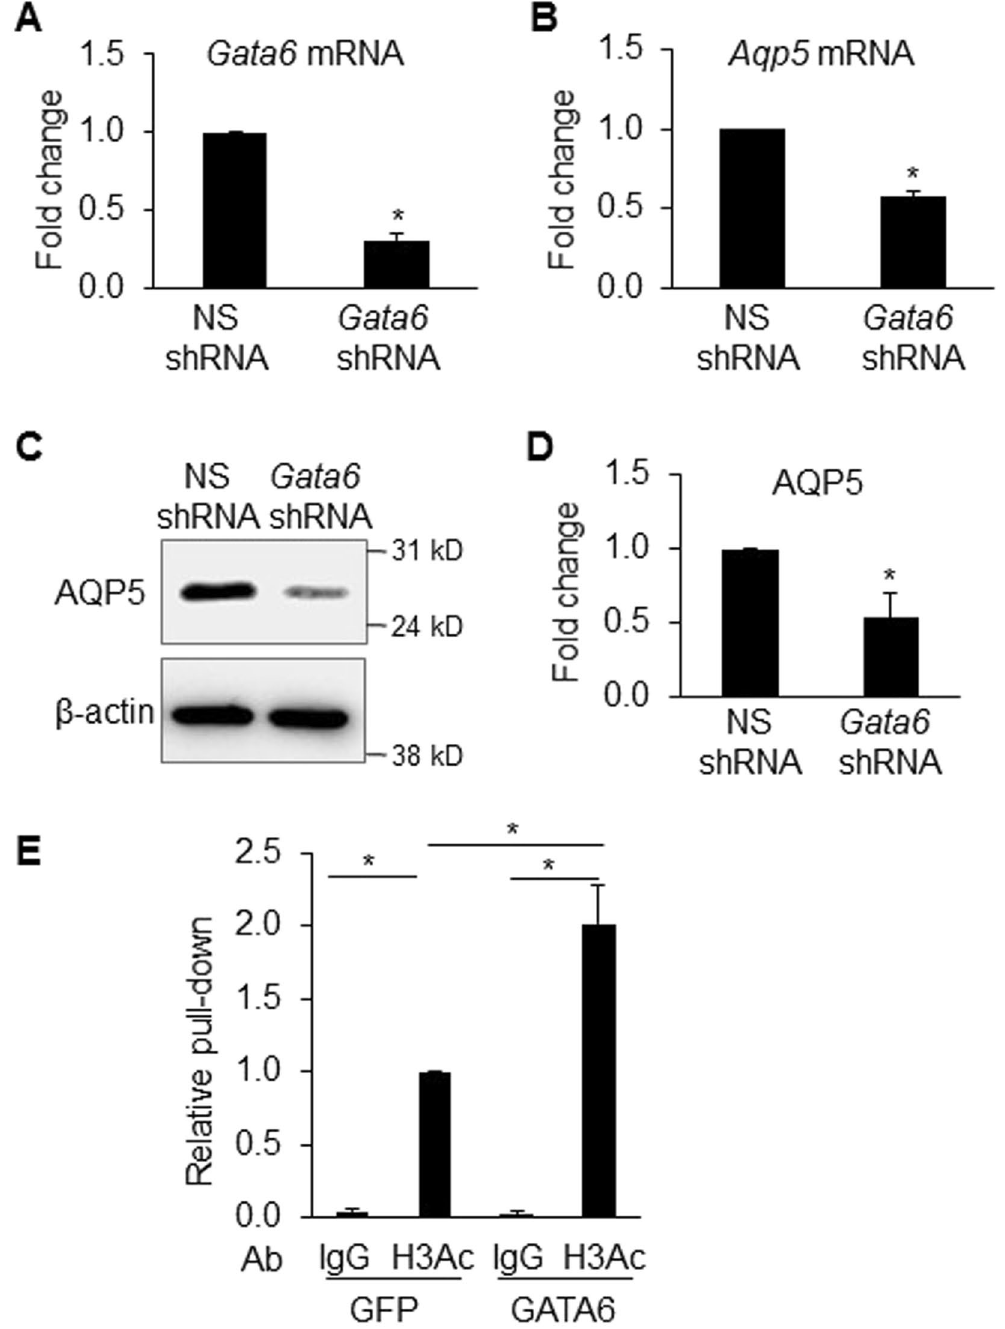
Figure 3. GATA6 regulation of AQP5 expression involves H3 acetylation. RNA and protein were harvested from MLE-15 cells transduced with lentivirus expressing Gata6 or control non-silencing shRNA (MOI = 2) for 3 days. qRT-PCR shows that knockdown of Gata6 ( A ) significantly decreases Aqp5 mRNA ( B ) and protein (AQP5 normalized to β -actin (42 kD)) ( C , D ) expression (n = 3, * p < 0.05 compared to non-silencing shRNA (NS-shRNA)). ( E ) ChIP with anti-acetyl-H3 Ab (H3Ac) demonstrates enrichment of H3 acetylation at the Aqp5 promoter/enhancer region homologous to the proximal 358-bp of the rat Aqp5 promoter using chromatin harvested from MLE-15 cells transduced with GATA6-expressing lentivirus or control (GFP) (MOI = 2) (n = 3, * p < 0.05). ChIP efficiency was calculated relative to control virus-transduced cells precipitated with H3Ac Ab, which was set as 1. Rabbit IgG pull-down is used as